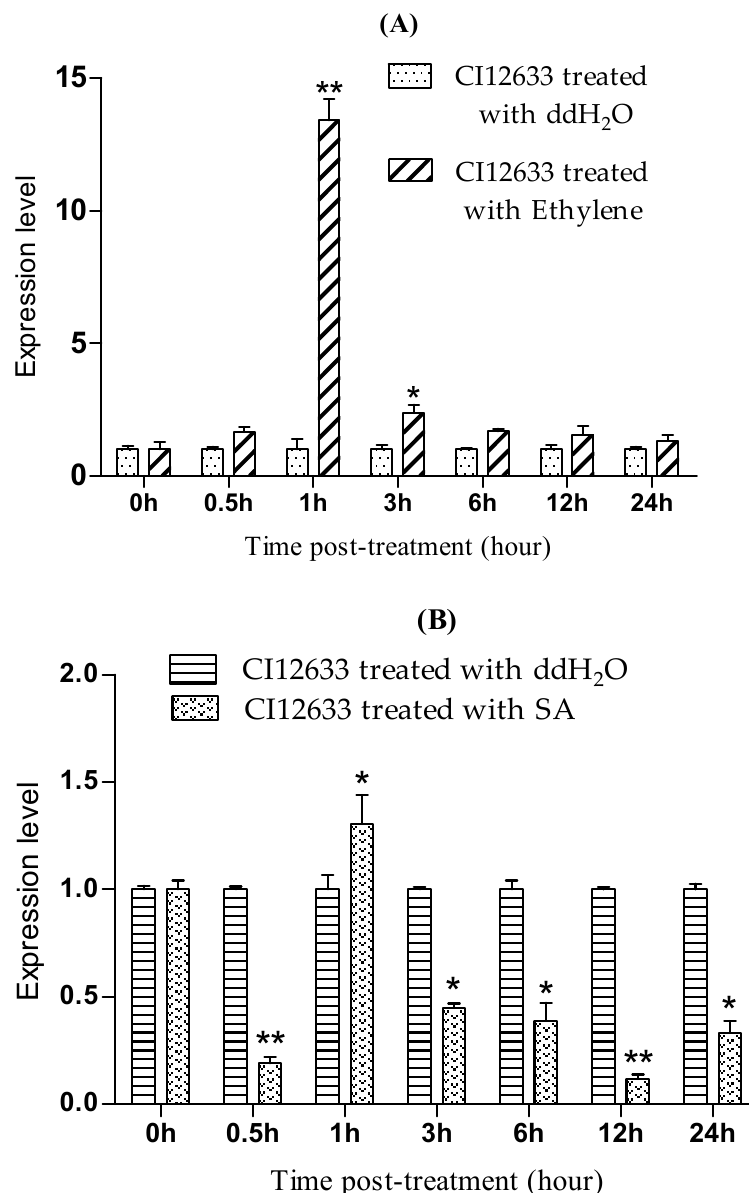
Figure 7. Expression trends of TaLecRK-IV.1 in CI12633 wheat plants treated with exogenous ET ( A ) and SA ( B ). Plants treated with sterile ddH 2 O were considered as control. The relative gene expression was quantified using the comparative 2 −∆∆ CT method and TaActin was used as the reference gene to normalize the expression level of TaLecRK-IV.1 . Asterisks indicate significant difference (* p < 0.05 or ** p < 0.01) based on the Student’s t -test.